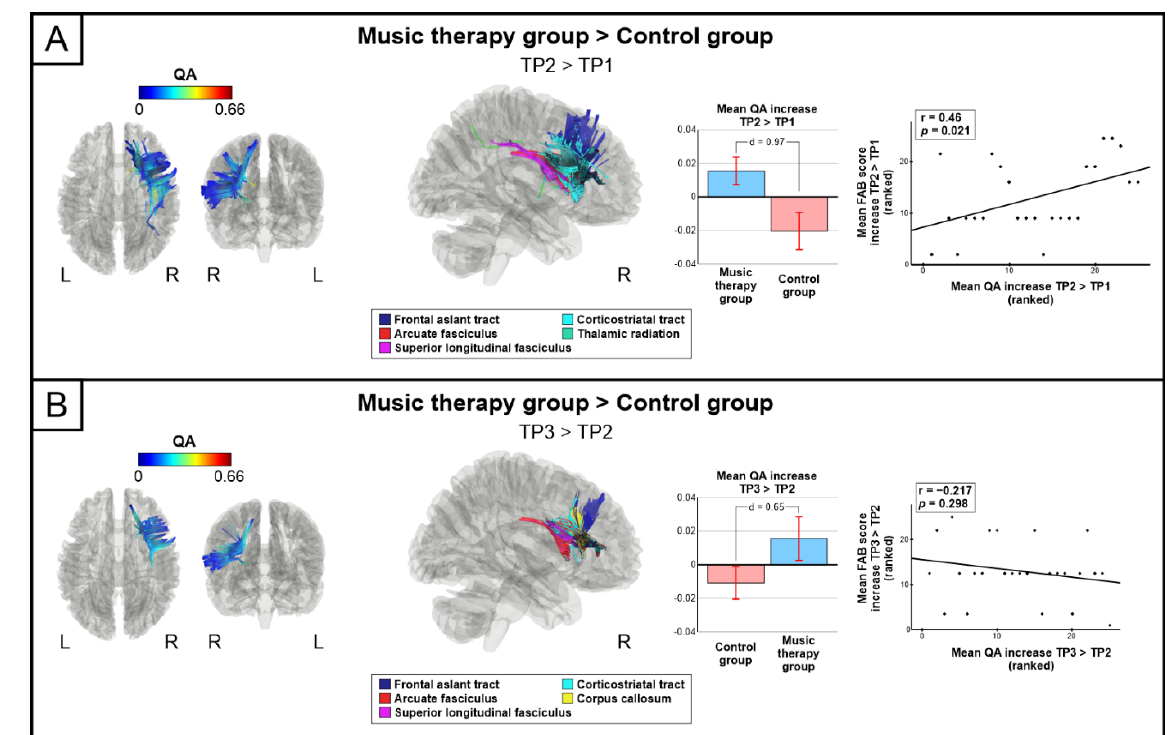
Figure 2. Music therapy induced structural white matter connectometry changes. Significant con- nectometry changes showing increased structural white matter connectivity between ( A ) music therapy and control group (TP2 > TP1) and ( B ) music therapy and control group (TP3 > TP2). Mean longitudinal QA change correlations (Spearman, two-tailed) to FAB score change are shown with scatter plots. Bar plots for mean QA in the significant connectivity results for both groups are shown: bar = mean, error-bar = standard error of mean, d = Cohen’s d, L = left, QA = quantitative anisotropy, R = Right, TP = time point.